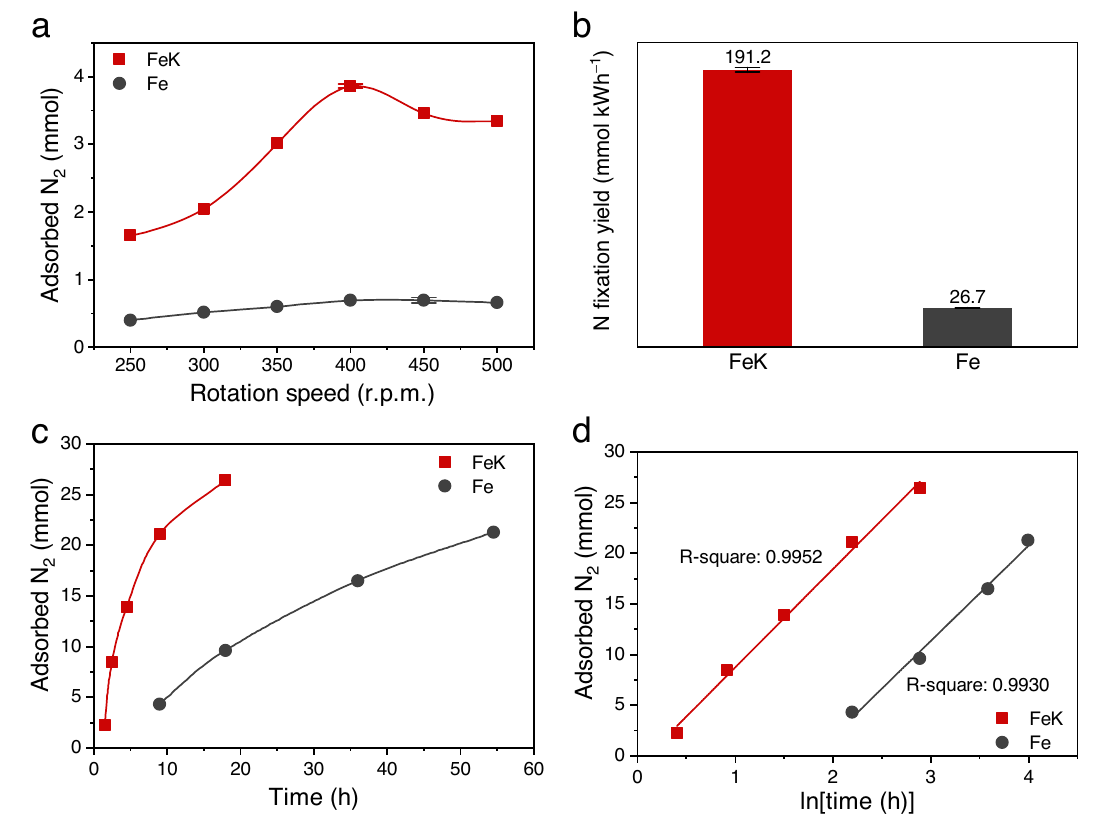
Fig. 2 | N 2 dissociation kinetics. a The amount of adsorbed N 2 with respect to rotation speed.The totalrotating cyclesfor FeKwere 108,000 cycles, and for pure Fe were 240,000 cycles. Data were normalized to 30,000 cycles (1hour at 500 r.p.m.). The data of Fe were adapted from ref. 29. b Highest N* fi xation activity comparison between FeK and Fe. N* fi xation yield was normalized by consumed energy (kWh) (FeK 400 r.p.m., Fe 450 r.p.m.). The data of Fe were adapted from